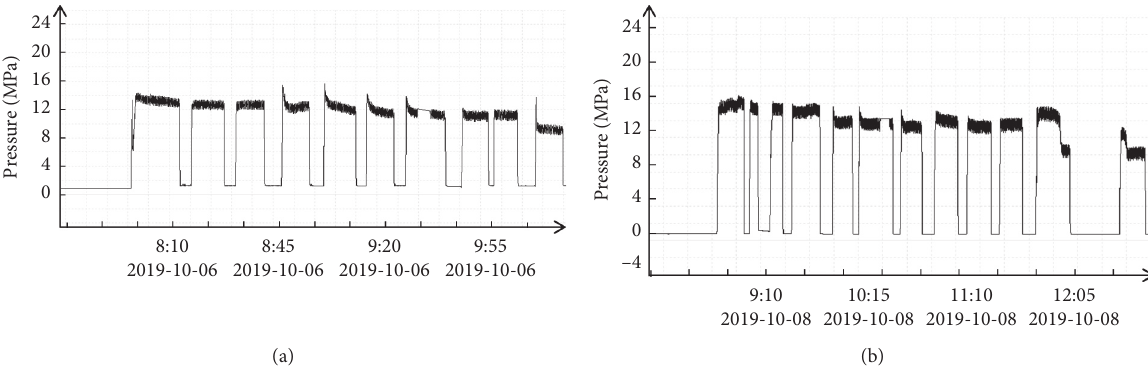
Figure 7: Hydraulic fracturing curve. (a) Borehole no. 27. (b) Borehole no. 28.